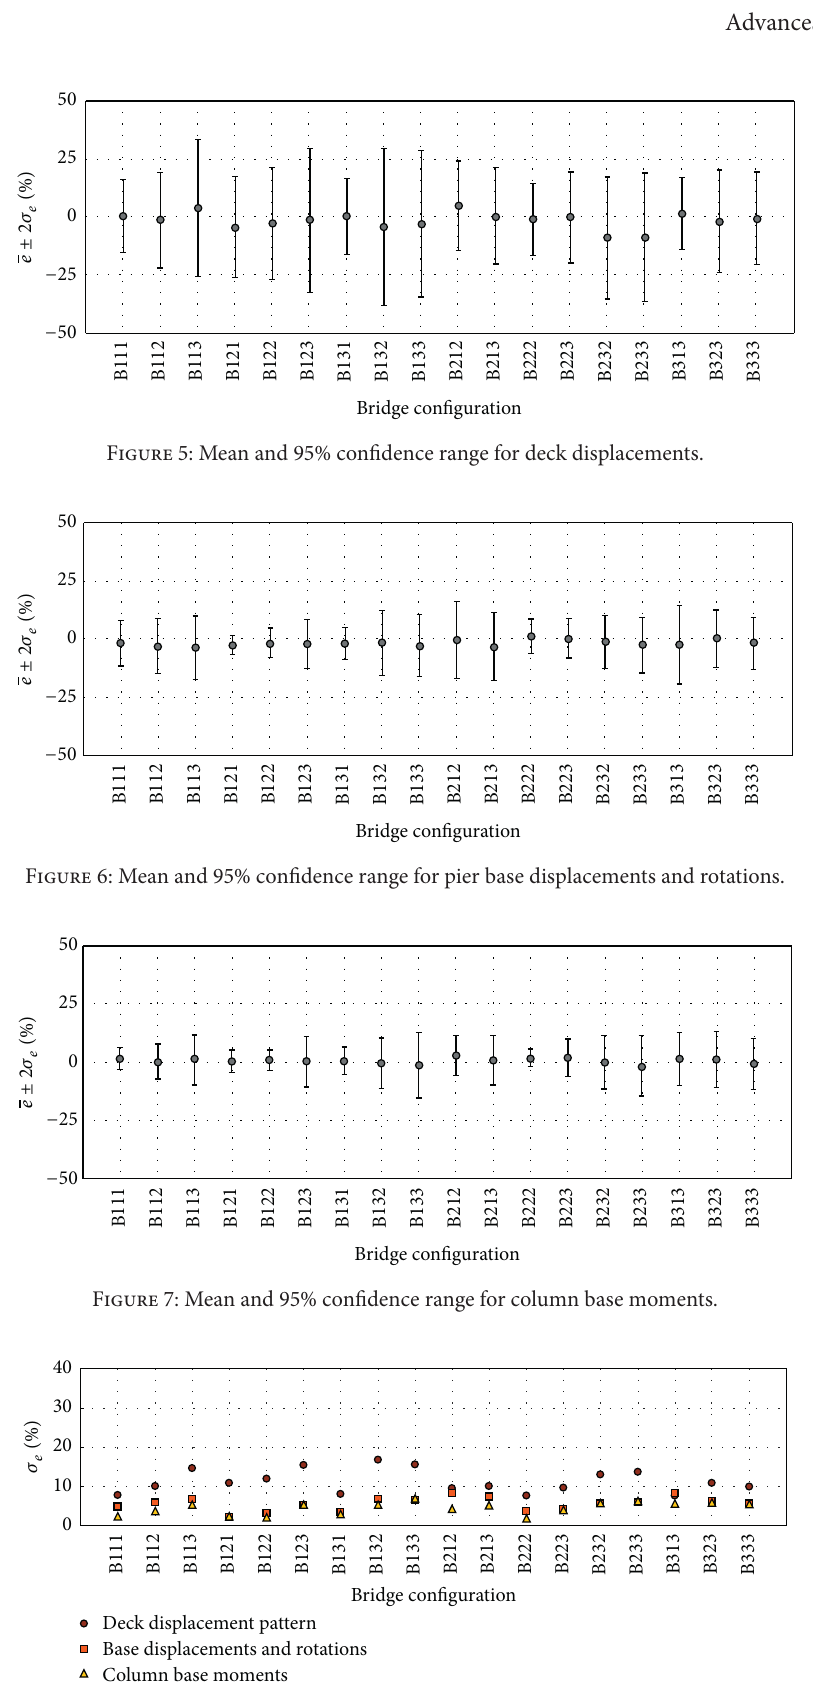
Figure 8: Standard deviation of the bridge response